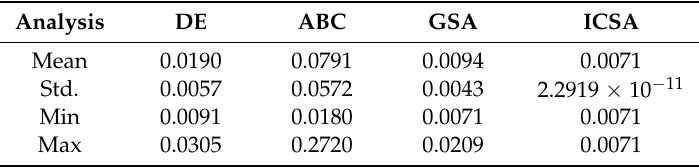
Table 7. Results of exact circuit model Cos t EM for motor